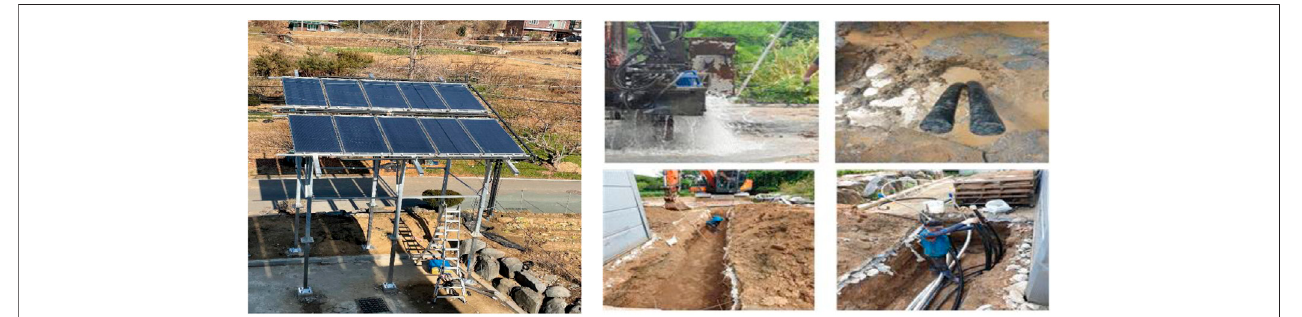
FIGURE 3 | Photovoltaic – thermal (PVT) and ground heat exchanger (GHX) installation for the polygeneration.